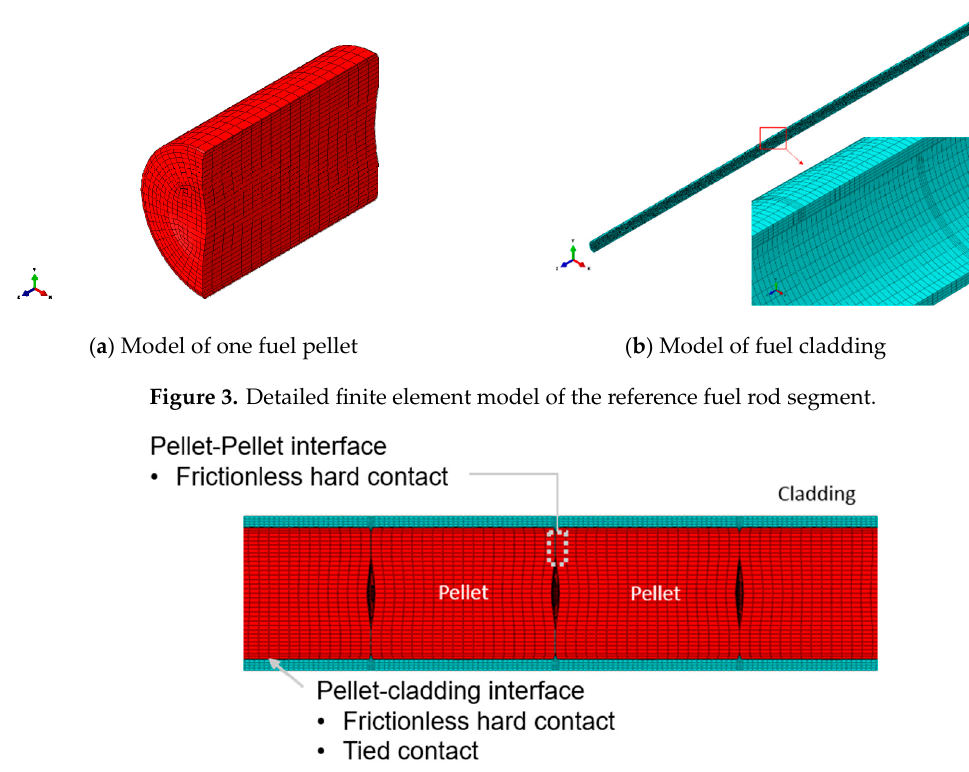
Figure 4. Interfacial conditions between pellets and cladding.